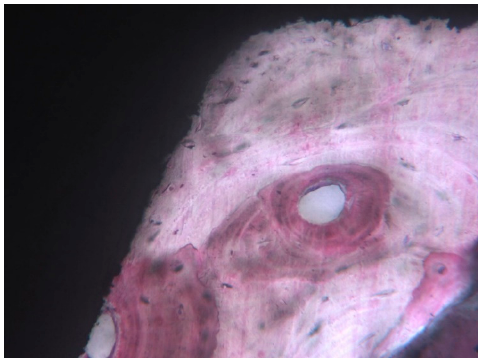
Figure 2. At high magnification, lamellar bone with Haversian canals were present inside the threads, in close proximity to the interface. Implant retrieved for fracture after 20 years of service: The implant supported a bridge. Courtesy of Dr. Carlo Mangano (toluidine blue and acid fuchsin staining, magnification 200 × ).